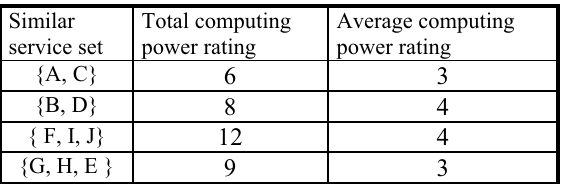
Table 2. Similar service set and total